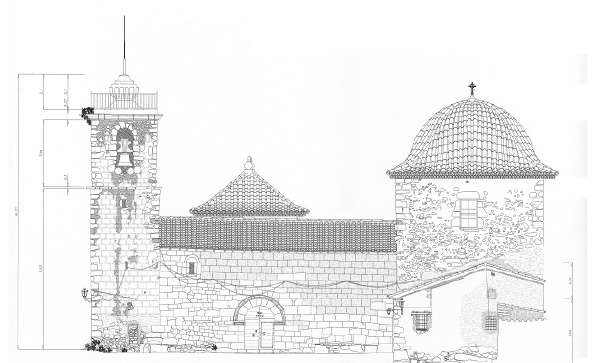
Fig. 2. Semi-manual survey: Elevation of the Church in La